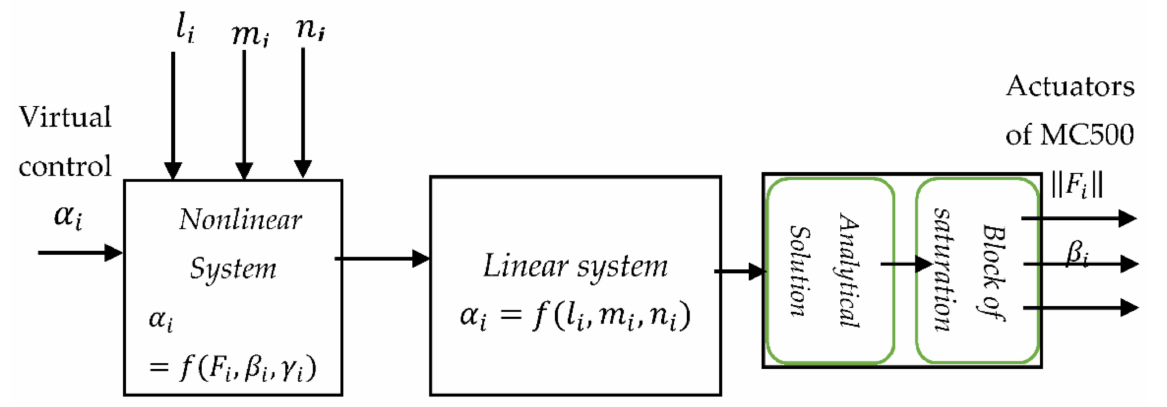
Figure 6. Block diagram of the proposed control